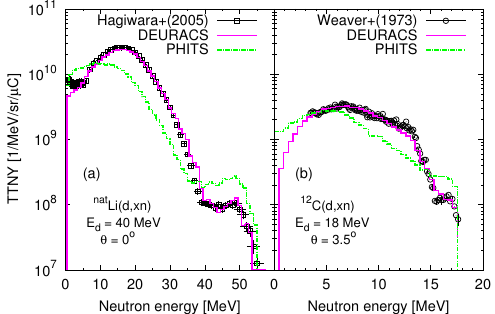
Figure 6. Calculated and experimental TTNYs from deuteron bombardment on (a) natural lithium at 40 MeV and (b) 12 C at 18 MeV. Experimental data taken from Refs. [30, 31], respectively. See text for the meaning of the